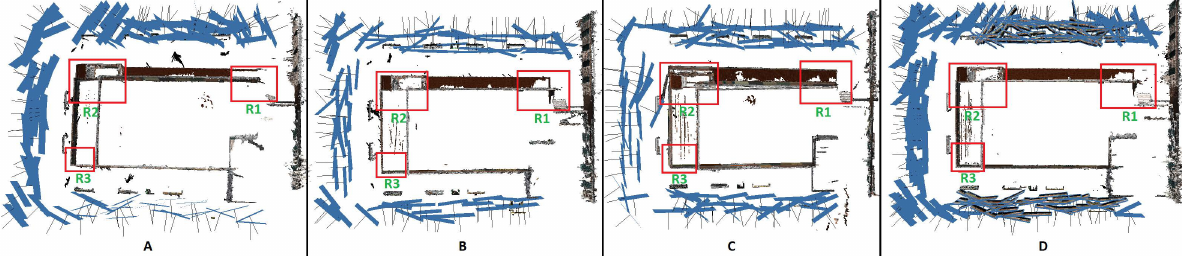
Figure 13. The captured images and the point clouds of the simulated building in centre pointing ( A ), façade pointing ( B ), hybrid ( C ), and combined centre & façade ( D ) imaging network design. Three areas (R1, R2, R3) are identified where a quality check was